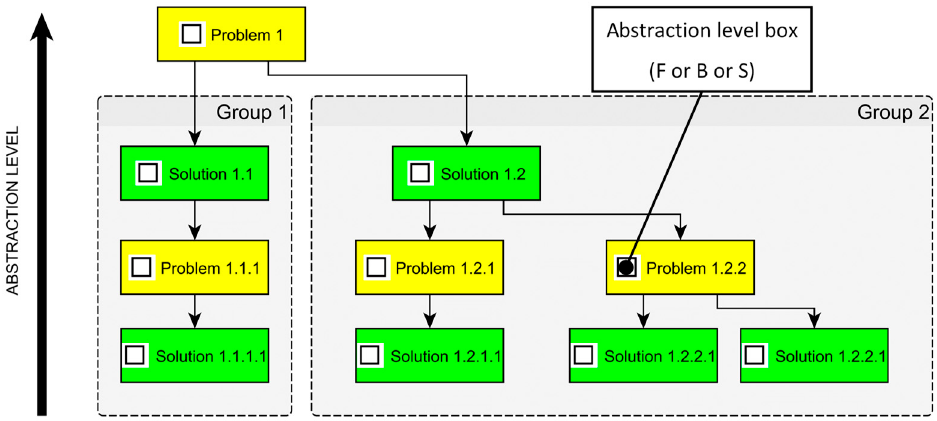
Figure 2. Generic example of the problem–solution network (PSN) used for modeling the AMBU-based open-source ventilators.